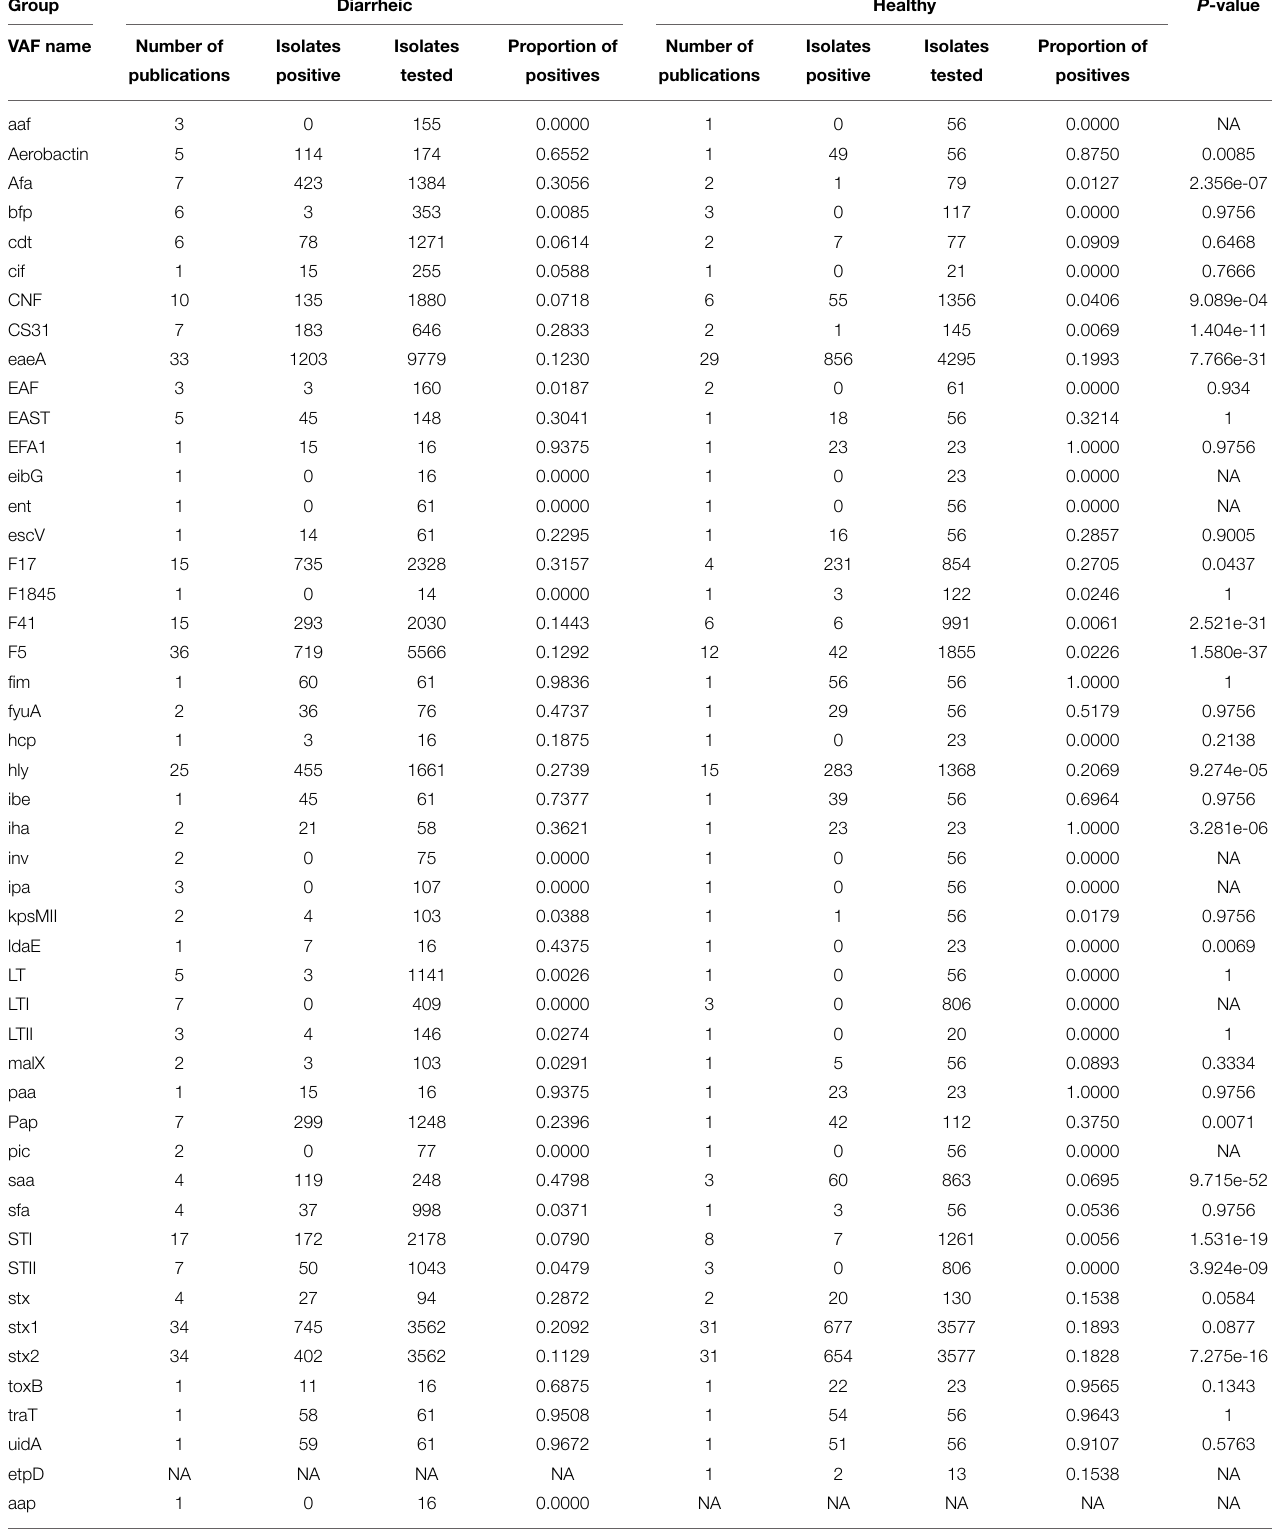
TABLE 1 | Comparison of study groups (healthy and diarrheic). Group Diarrheic